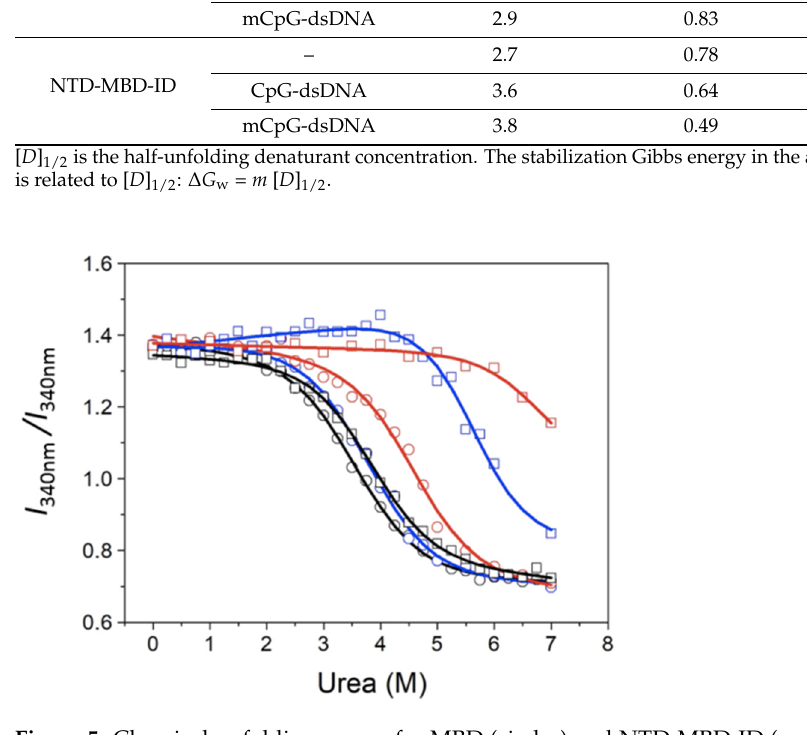
Figure 5. Chemical unfolding curves for MBD (circles) and NTD-MBD-ID (squares). The ratio of fluorescence intensities at 330 and 350 nm was represented as a function of the urea concentration: free protein (black), protein bound to unmethylated CpG-dsDNA (blue), and methylated mCpG- dsDNA (red). Table 5. Thermal unfolding parameters for MBD and NTD-MBD-ID at pH 7, estimated by analyzing the denaturant dependence of the fluorescence intensity ratio I 330 / I 350